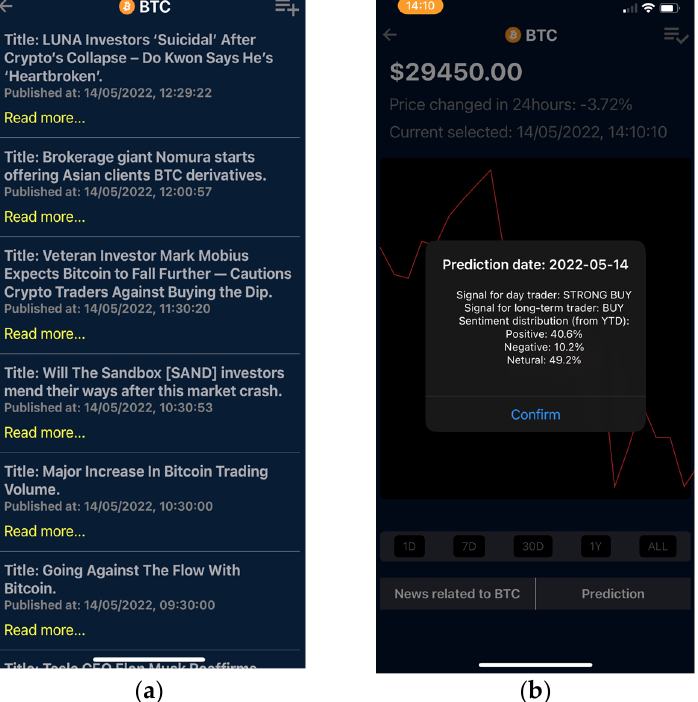
Figure 11. Prototype screen-dump of ( a ) news function and ( b ) prediction function.